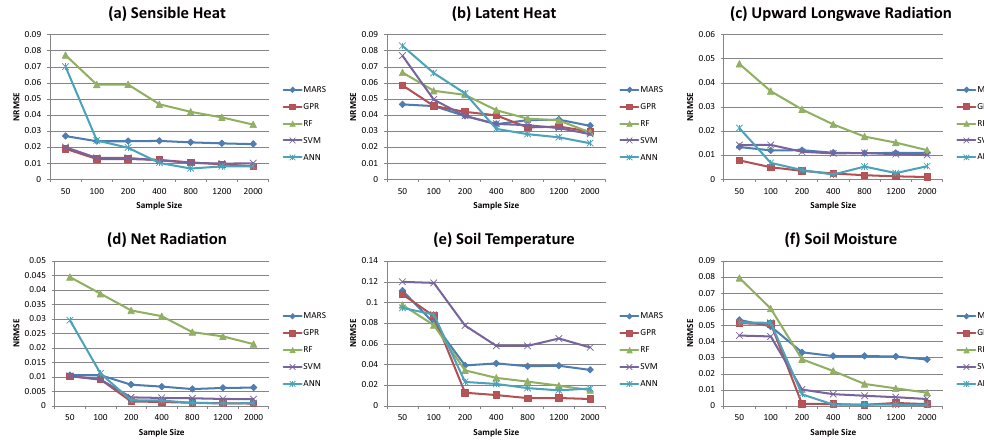
Figure 2. Inter-comparison of five surrogate modeling methods: error of testing